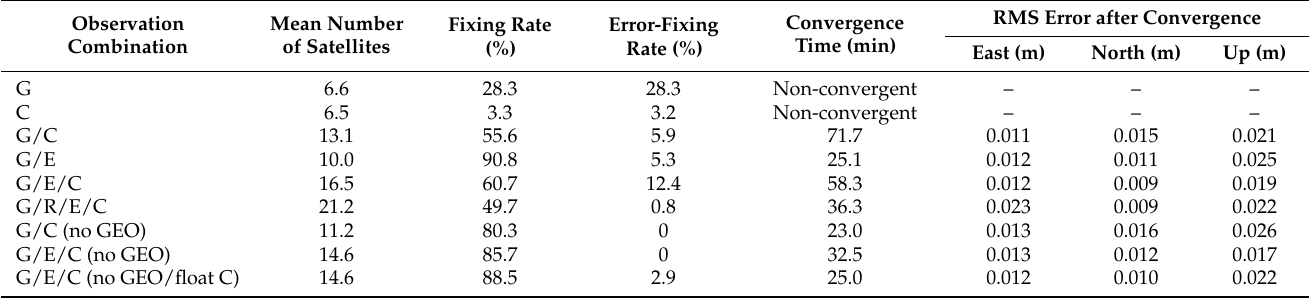
Table 6. Solutions for single-frequency observation combinations (G, GPS; R, GLONASS; E, Galileo; C,